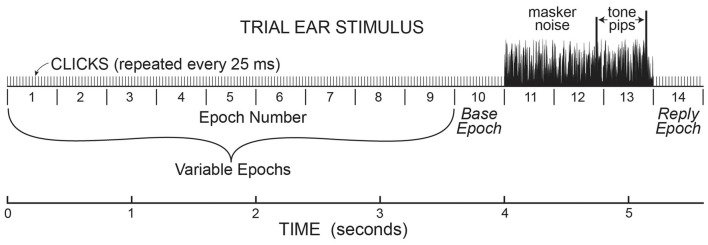
A cartoon illustrating the stimulus paradigm for the sounds presented in the task ear in one trial. This paradigm established the timing for the analysis of ear-canal noise in the opposite ear, where no sound was presented. In the task ear, stimuli were presented in 400 ms “Epochs” with 50 dB pSPL clicks presented every 25 ms throughout. There were 1–10 (randomly chosen) Epochs before three Epochs with 50 dB SPL masker noise, followed by one Epoch at the end. The Epochs from “base” to “reply” were present on every trial. The last two Epochs with masker noise (Epochs 12 & 13) also contained tone pips that were the same amplitude in the no-task trials, but different amplitudes in task trials. At the end of each trial during the task, subjects had to push a button to indicate which tone pip was louder.